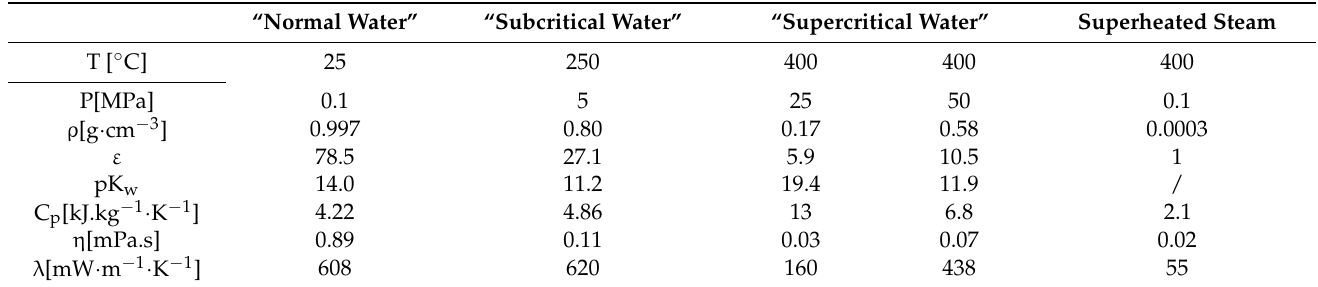
Table 7. Physicochemical properties of water as a function of temperature and pressure. Reprinted with permission from Reference [111]. Copyright 1999 Wiley.